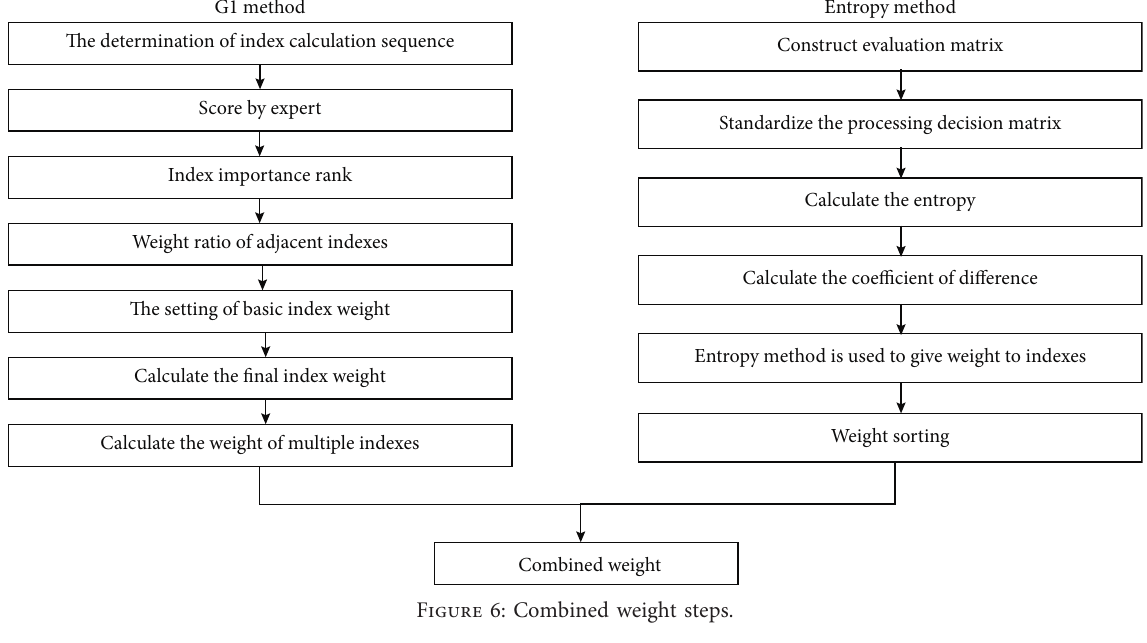
Figure 6: Combined weight